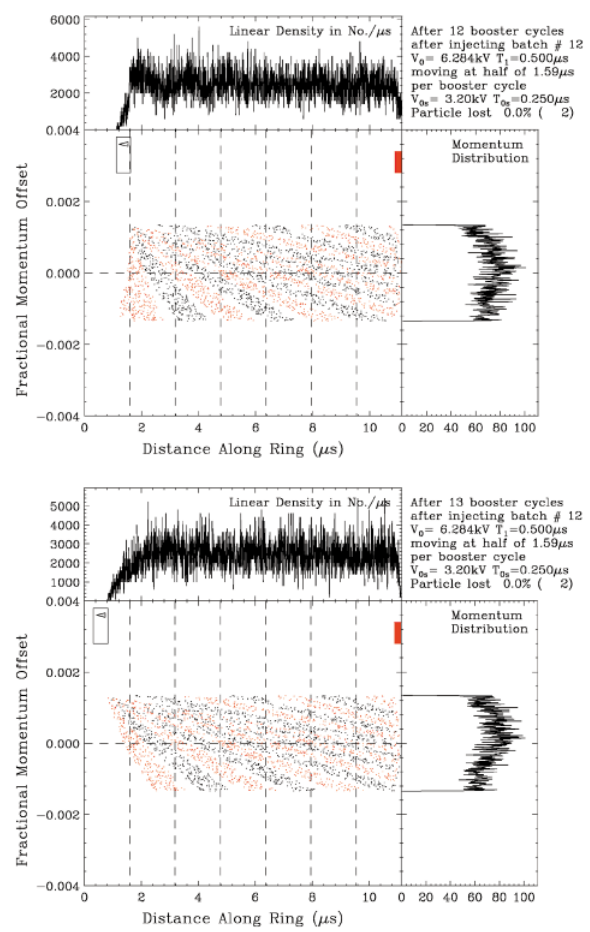
FIG. 8. (Color) Same as Fig. 7, but with the width of the moving barrier reduced to 0.5 m s and strength increased to 6.2842 kV. At injection of the first batch, the left side of the barrier was placed at 6.7 T b . Top: One booster cycle after the injection of the 12th batch between 0.2 T b and 1.2 T b , or 12 booster cycles after the injection of the first batch. Bottom: Another booster cycle